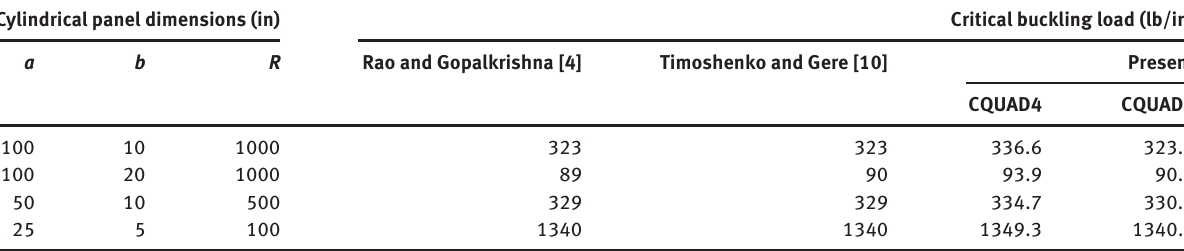
Table 1 Comparison of critical buckling load for isotropic cylindrical panels subjected to uniform in-plane load ( ν = 0.3, t = 0.096 in, E = 10 × 10 6